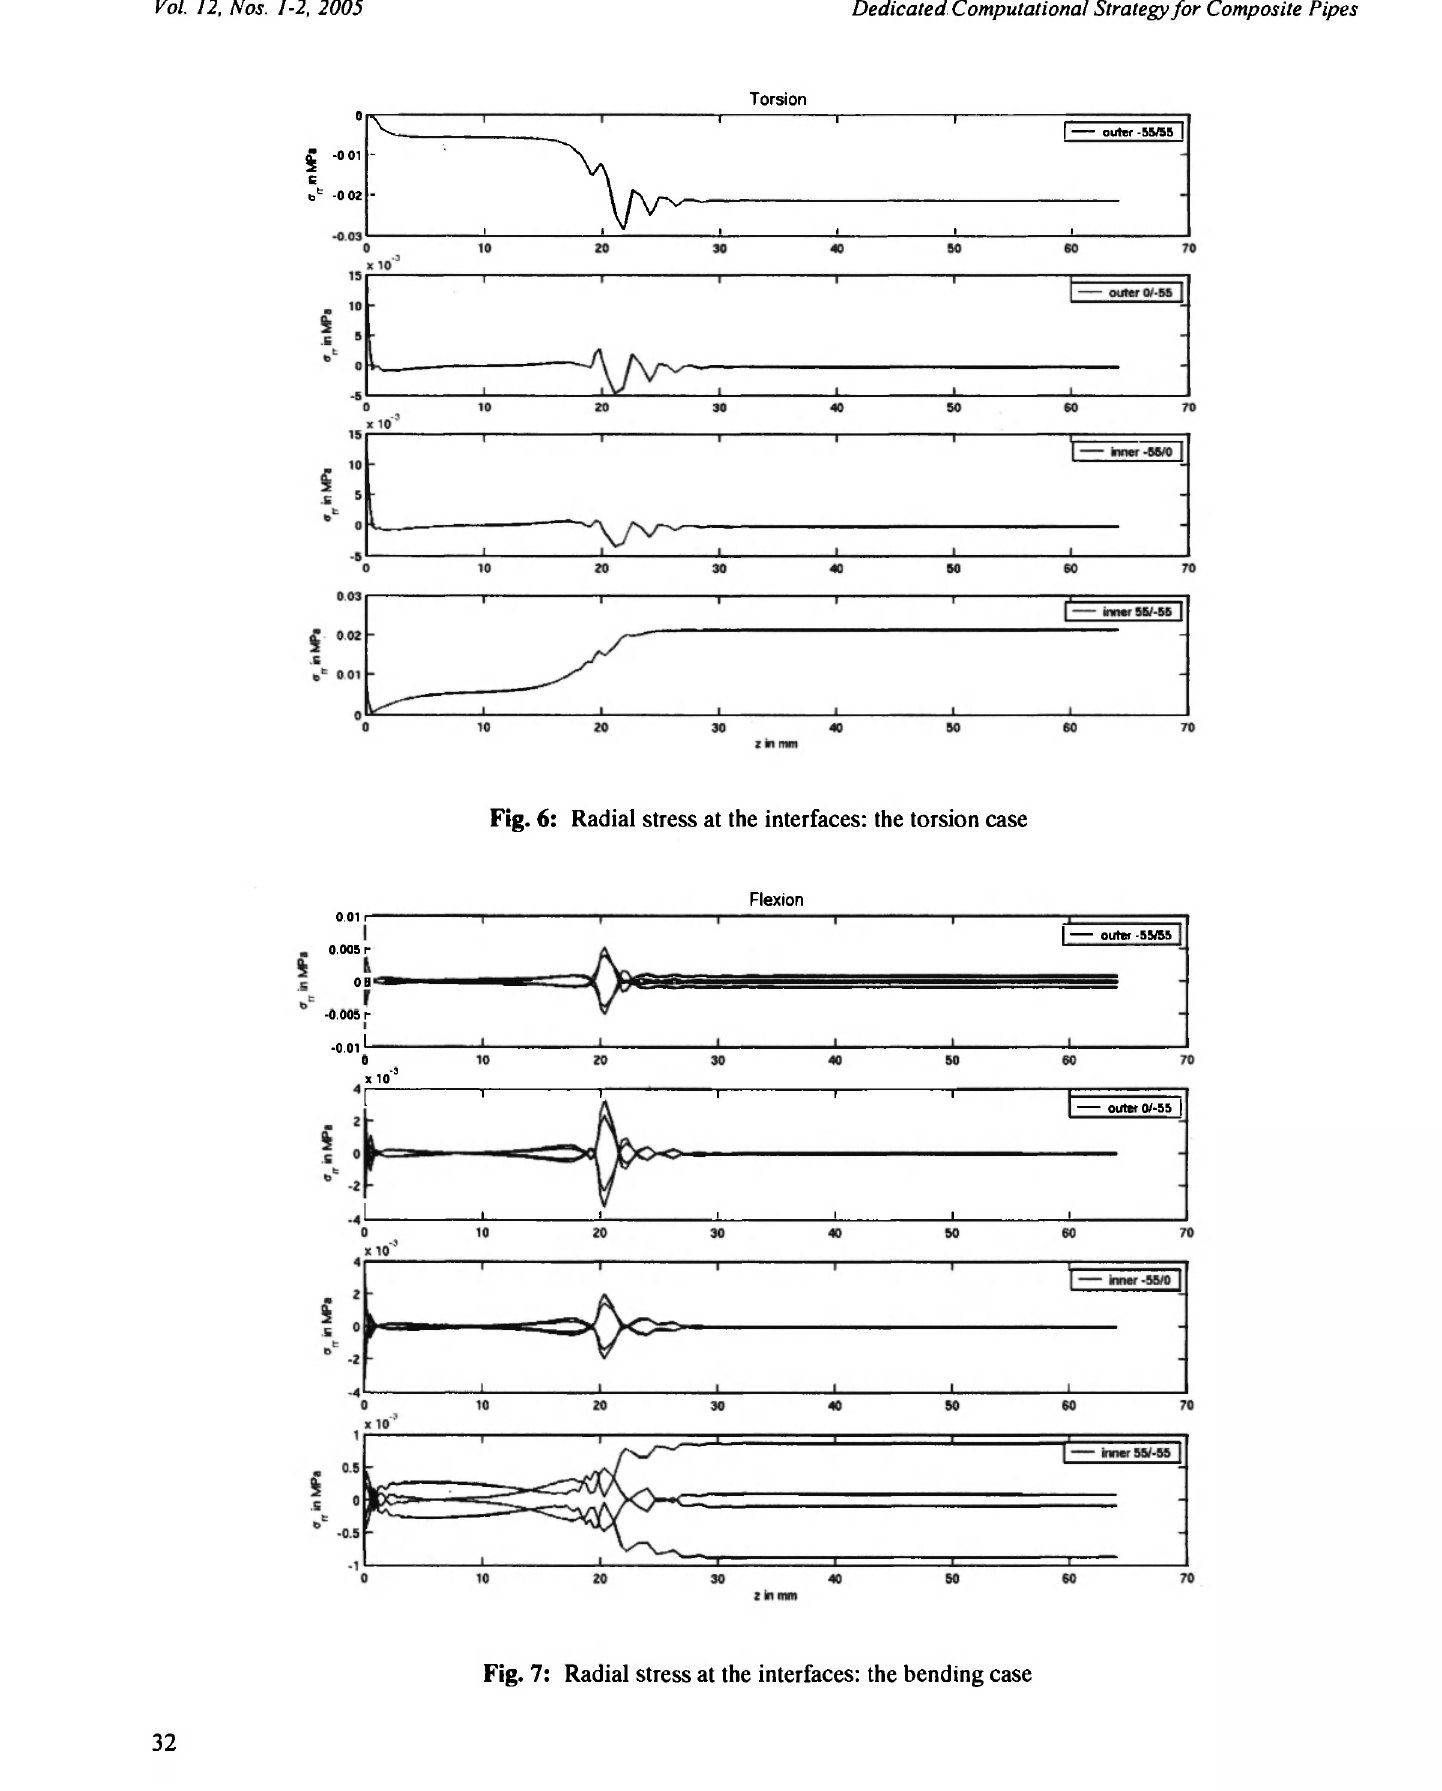
Fig. 6: Radial stress at the interfaces: the torsion case